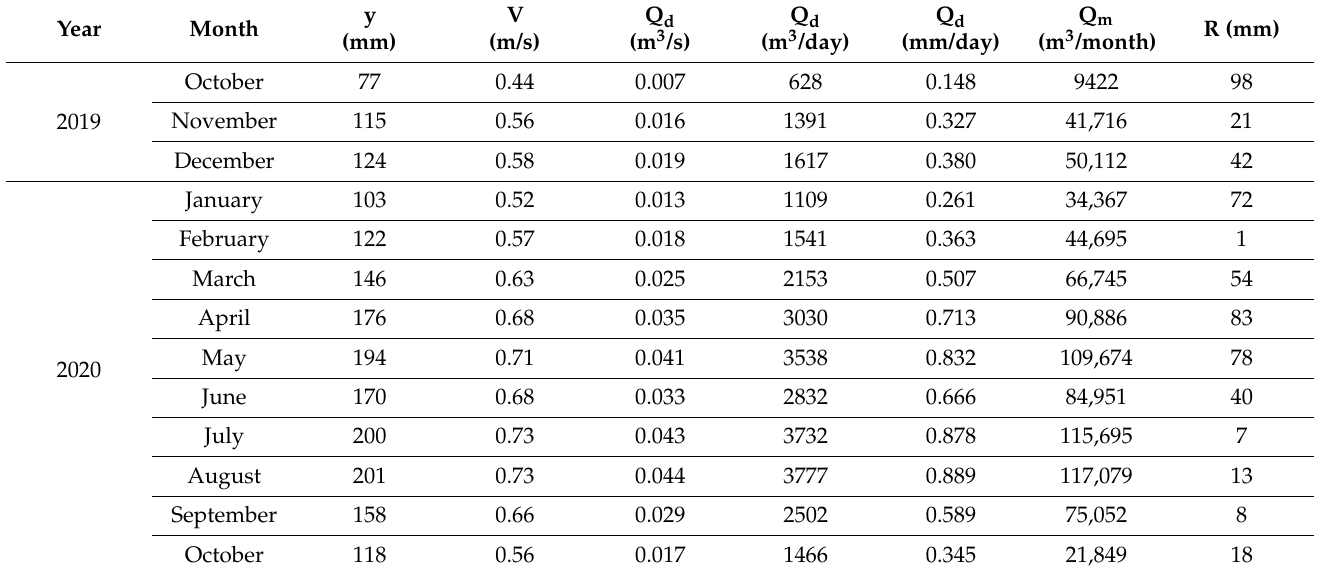
Table 8. Average water level of the monitored outlet (y, mm), average velocity (V, m/s) during